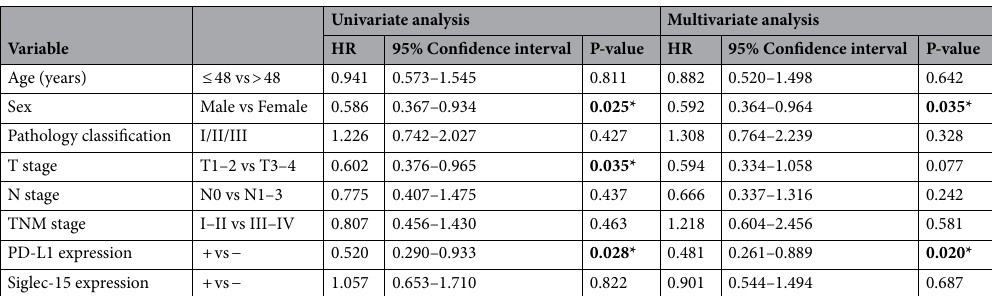
Table 4. Univariate and multivariate Cox proportional hazard analyses of clinicopathologic variables for the OS rate. Siglec-15 Sialic acid-binding immunoglobulin-like lectin 15, PD-L1 programmed cell death-Ligand 1, WHO World Health Organization, OS overall survival. The bold value represents p>0.05, indicating that the difference is statistically significant.